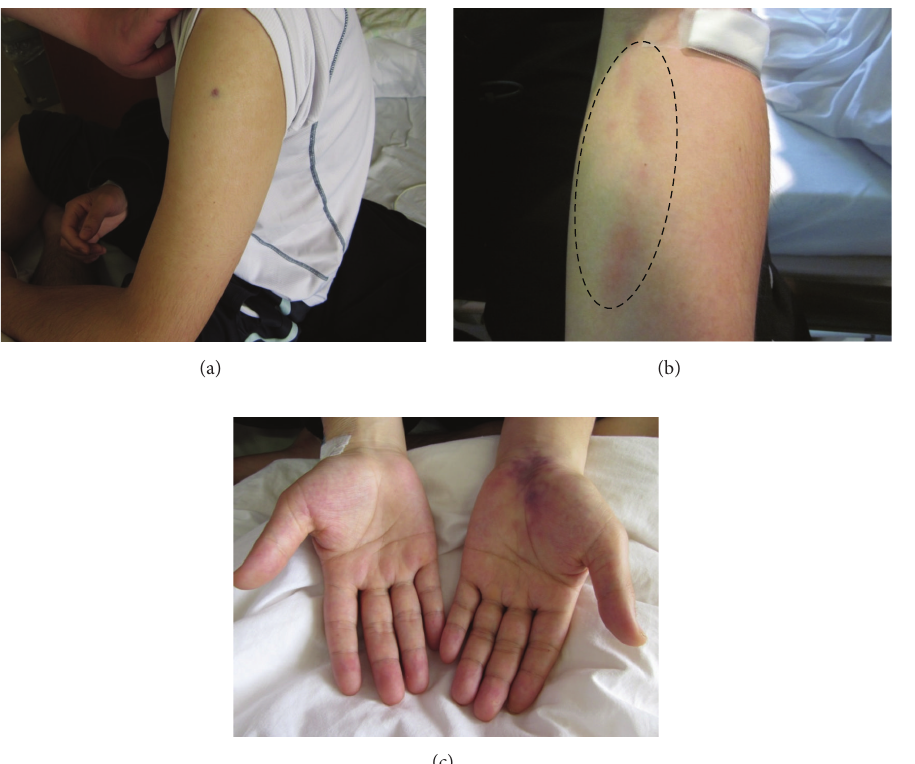
Figure 1: Clinical manifestations on admission. Physical examination identified swollen left upper arm (a), erythema nodosum on the left forearm (b), and purpura on the left wrist joint (c), suggesting a deficiency of blood supply on the left